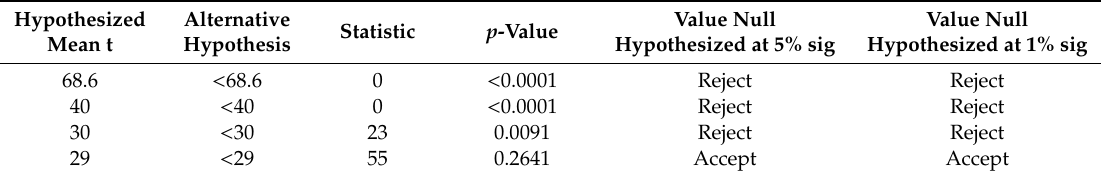
Table 13. Results of Wilcoxon test for Aa.